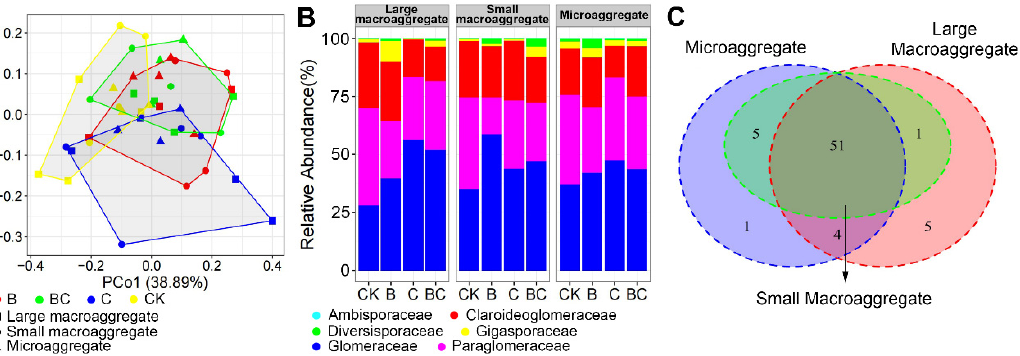
Figure 3. Principal coordinate analysis of arbuscular mycorrhizal (AM) fungal community compositions among treatments ( A ); relative abundance of AM fungal families among treatments in different aggregate fractions ( B ); Venn diagram showing the unique and shared AM fungal OTUs among different aggregate fractions ( C ). Abbreviations: CK, control; B, biochar addition; C, compost addition. At family level, the relative abundance of Diversisporaceae ( F = 7.65, p = 0.009) and Paraglomeraceae ( F = 6.34, p = 0.02) were significantly affected by biochar addition.